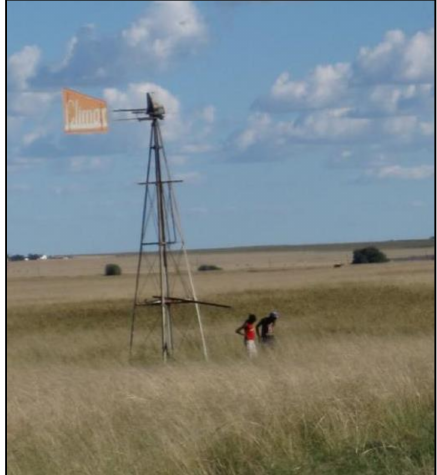
Figure 2. A tap connected to a windmill.